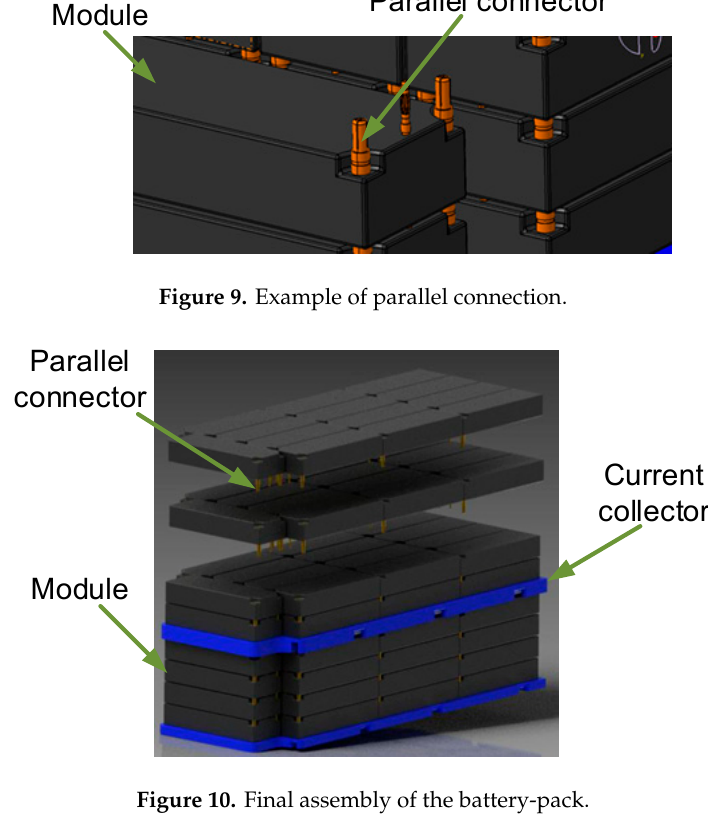
Figure 8. Series connection of the modules.